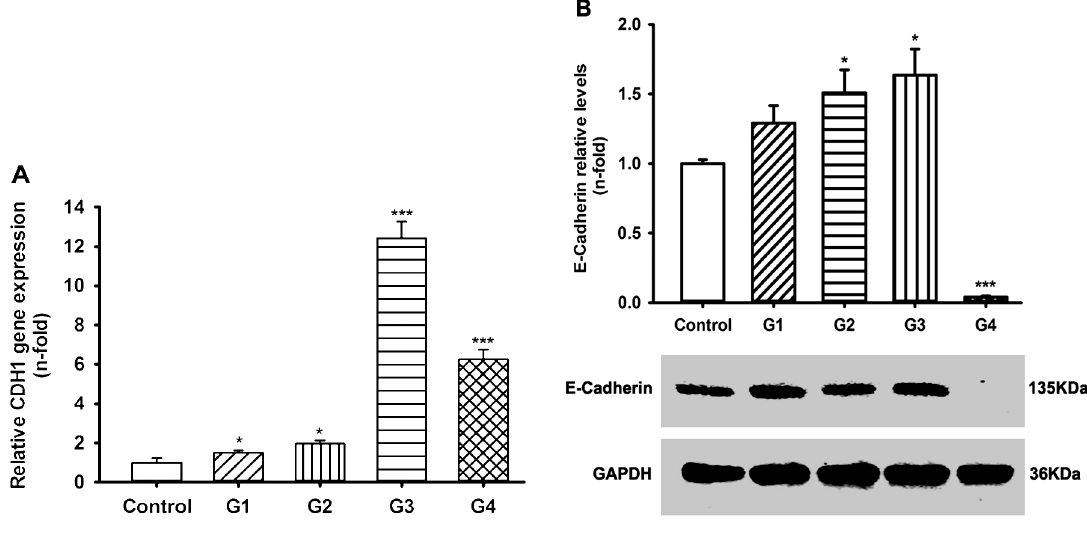
Figure 6. RSV-induced E-cadherin expression in 16HBE cells. ( A ) Total RNA was analyzed for CADHERIN 1 (CDH1) mRNA levels; and ( B ) Whole-cell lysates were analyzed for E-cadherin protein levels using western blotting. Symbols signify statistical significance, where * p < 0.05, ** p < 0.01, and *** p < 0.001 compared with control (non-inoculated